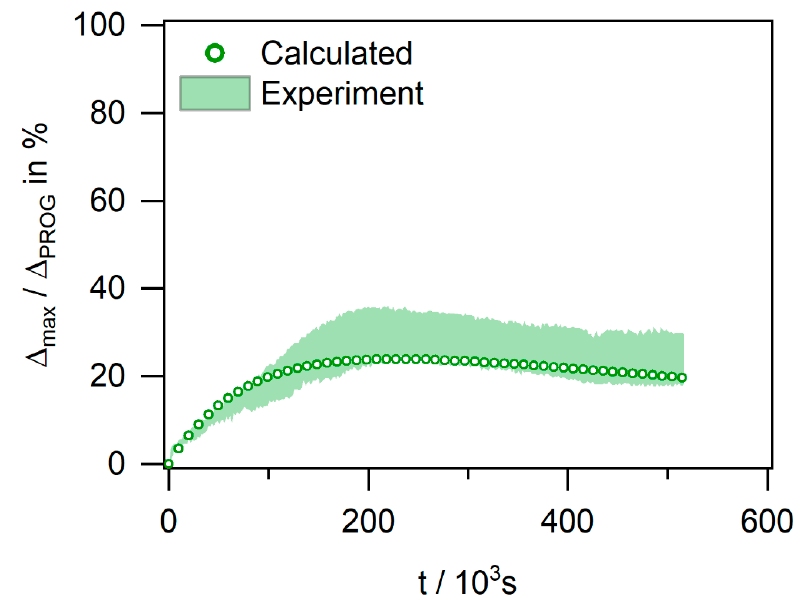
Figure 15. Experimental (green scatter band) and calculated (green circles) evolution of recovery strain with time for SMP-E. Programming strain: 50% ( ∆ ∗ = 30%). Solvent: ethanol. End load: 1.0 MPa. Rheological model: Lethersich [48]. Model: Figure 8a. Input parameters: Table 3.